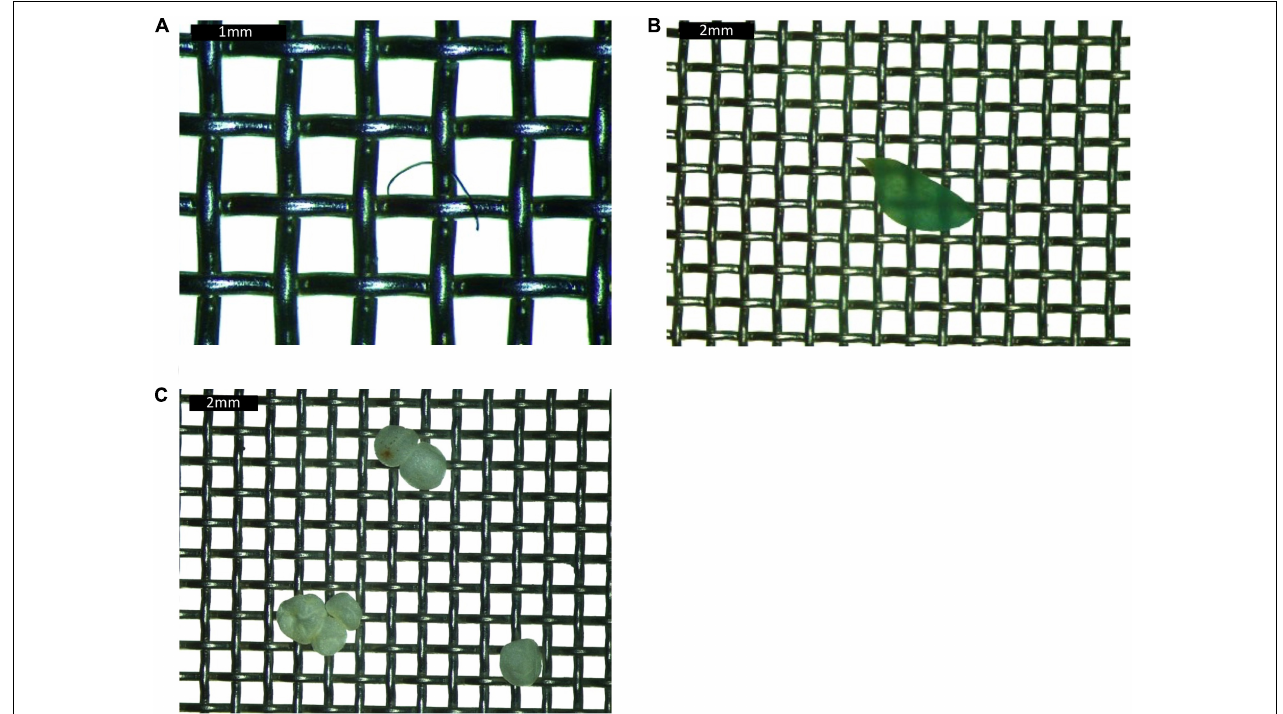
FIGURE 2 | Images of (A) fiber, (B) film, and (C) fragment collected from the gastrointestinal tract of fish. Each grid is 1 × 1 mm